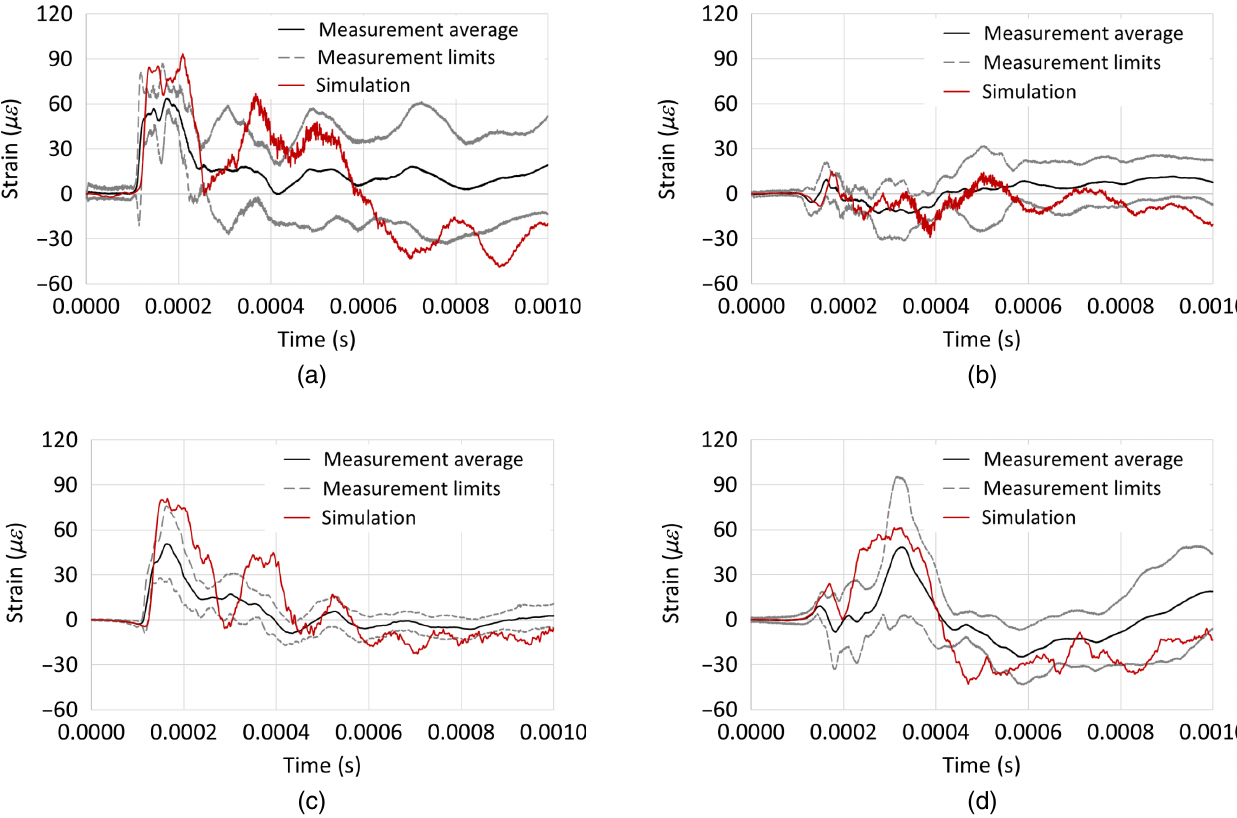
FIG. 16. Dynamic strain responses in the back of the target. (a) Sensor H (center-beam direction). (b) Sensor J (center-transverse direction). (c) Sensor F (left-beam direction). (d) Sensor L (right-transverse direction).